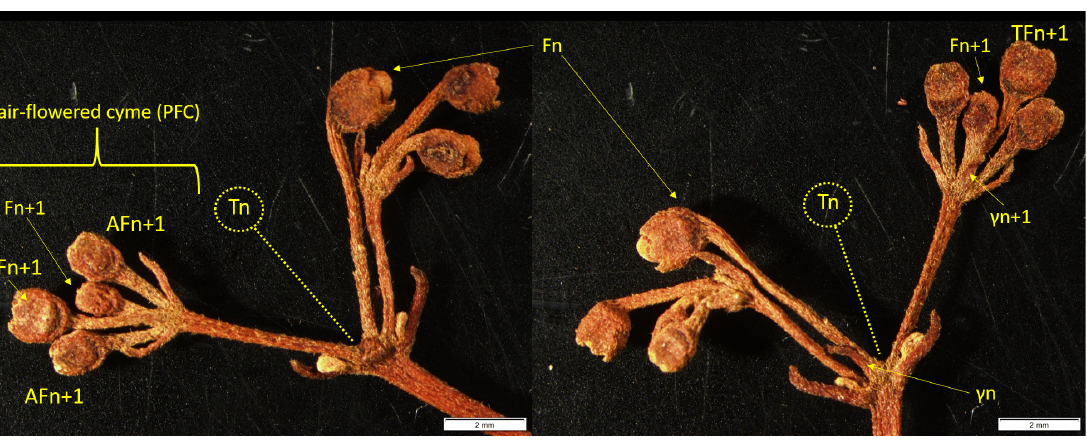
Fig. 4. Recto and verso photographs of an ultimate inflorescence axis of Bopopia parviflora Munzinger & J.R.Morel gen. et sp. nov., showing the pair-flowered cyme